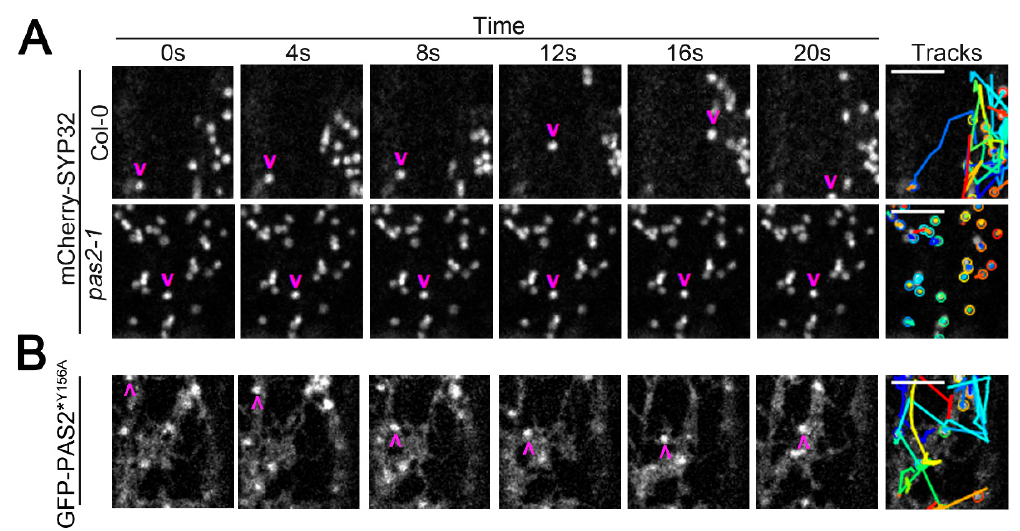
Figure 4. The pas2-1 mutant specifically disrupts the Golgi motility, which was rescued by pPAS2:: GFP- PAS2 Y156A . ( A ) Analysis of Golgi motility in control (Col-0) and pas2-1 seedlings . ( B ) Analysis of Golgi motility in pas2-1 seedlings transformed with pPAS2:: GFP- PAS2 Y156A . A representative image and tracking analysis were shown ( n = 30 per genotype). A series of single-frame images was taken to show the locations of mCherry-SYP32 and GFP-PAS2 Y156A labeled particles at multiple time points. Arrows indicate the location of one representative particle. Tracks indicate the trajectories of all particles (marked by circles) within 20 s. Different colors represent for different particles been tracked. Bar = 5 μ M.